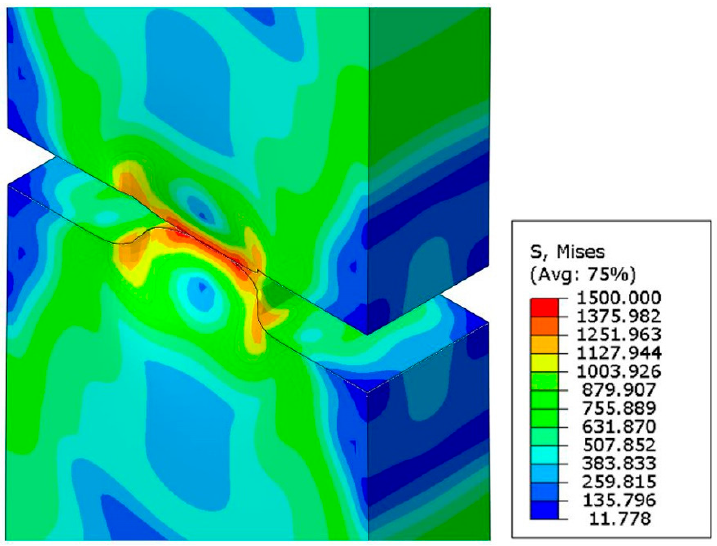
Figure 20. Von Mises stresses in the final stage of fracture.